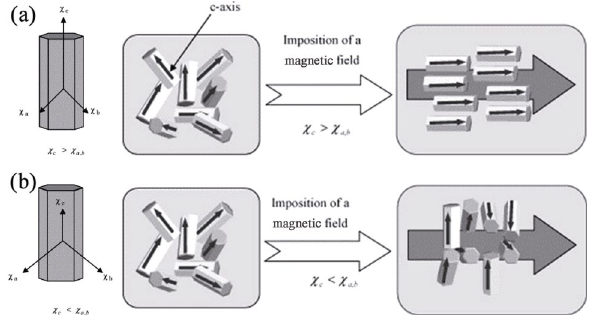
Fig. 10 Schematic diagram of the effect of a magnetic field on the alignment of rod-like particles belonging to the hexagonal crystal lattice: (a) χ . Reproduced with permission from Ref. [2], © Elsevier , a b B.V.